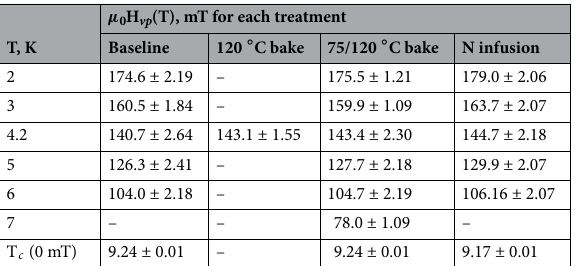
2 2 (T c (0 mT)), assuming a linear T dependence.